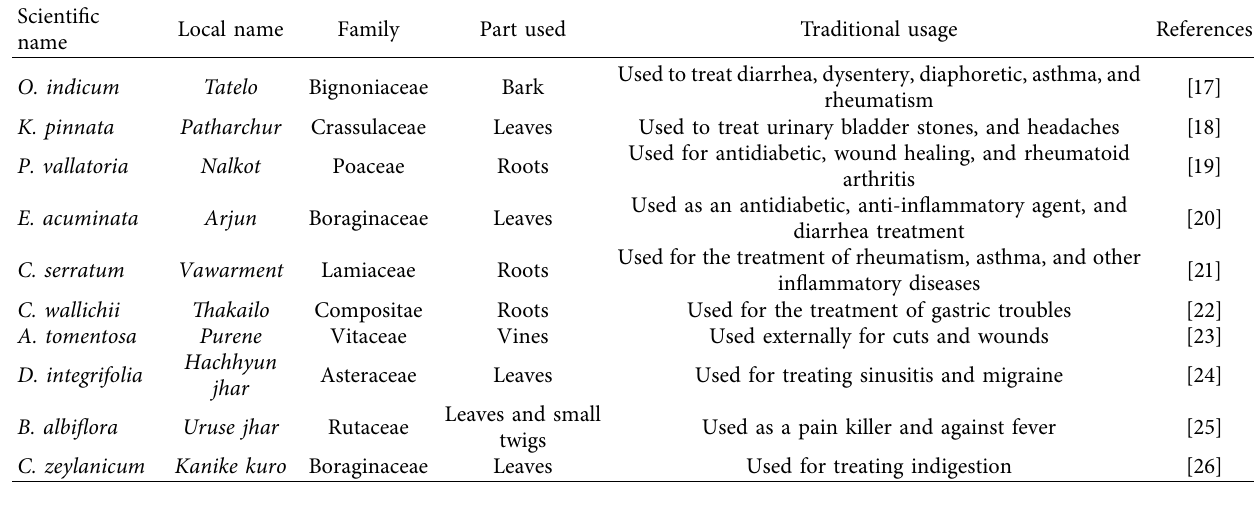
Table 1: Description of the selected medicinal plants.